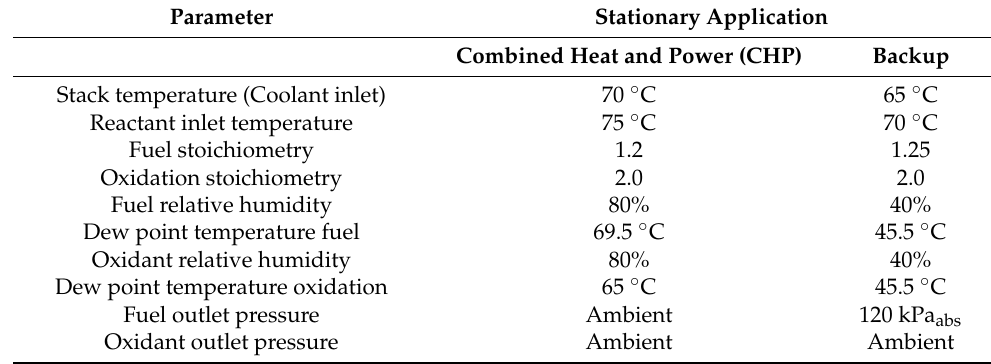
Table 8. Recommended nominal reference operating conditions for stationary application in STACK- TEST